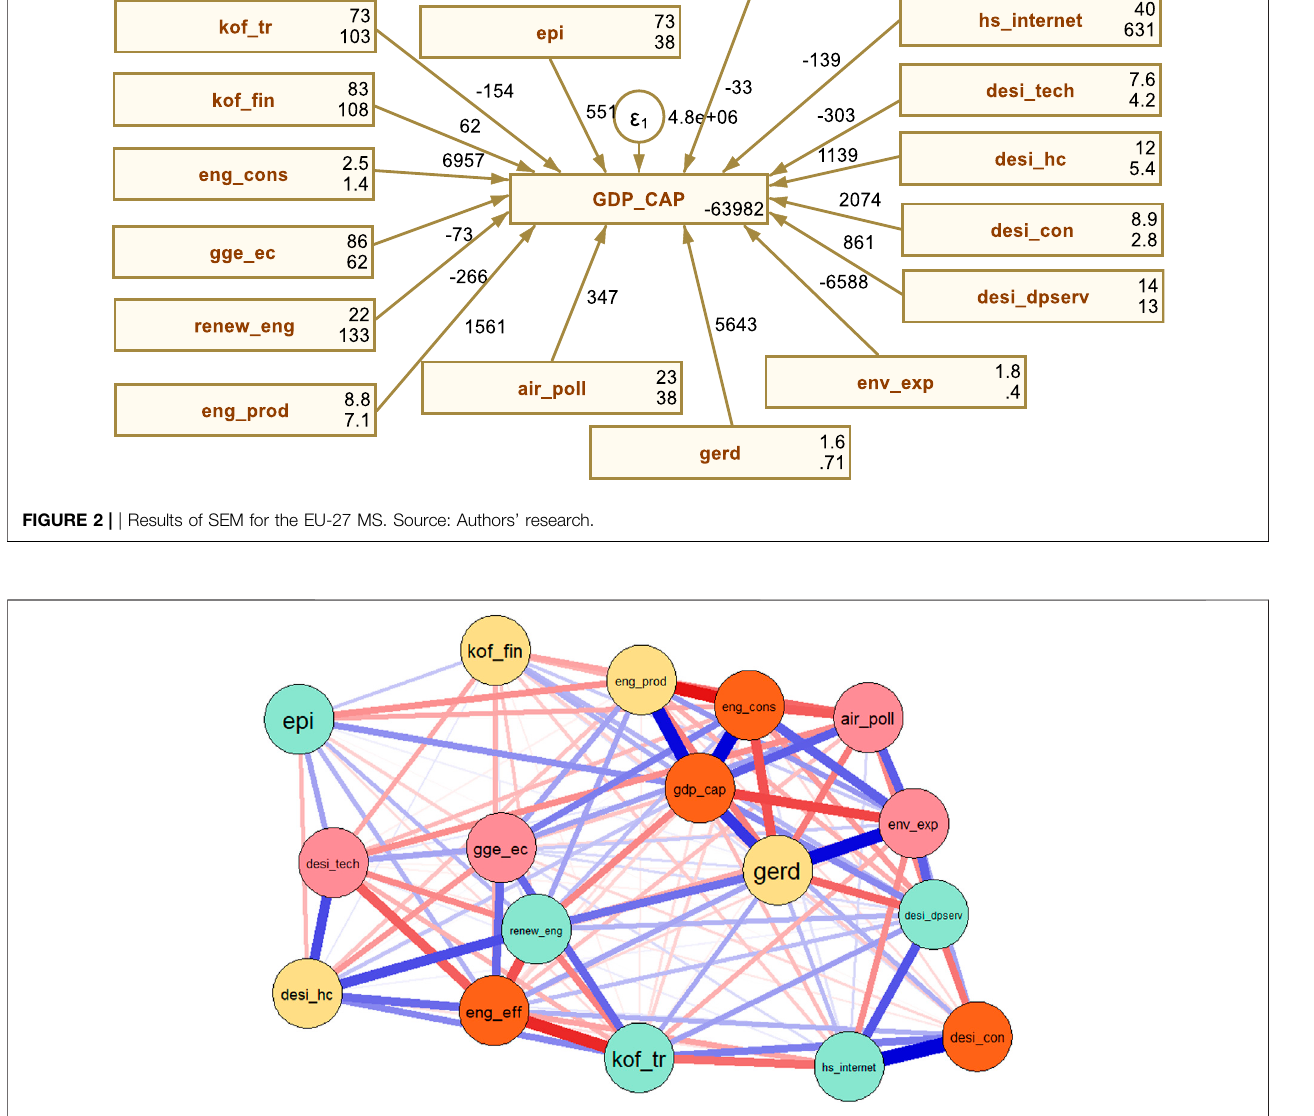
Frontiers in Environmental Science |